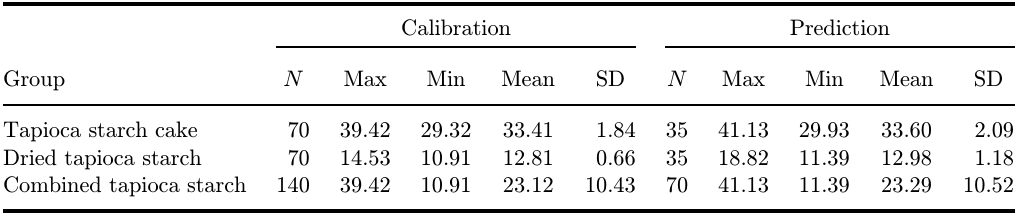
Table 1. Moisture content (% wet basis) of tapioca starch measured by the standard method used to develop the prediction model and validate the test